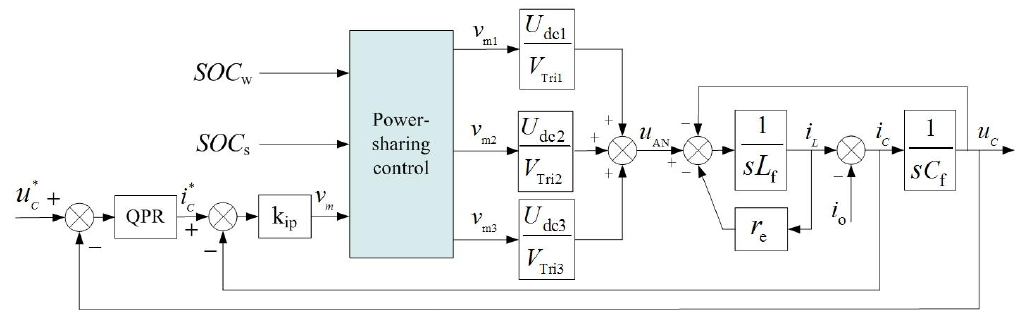
Figure 7. Control of the inverter-link with a power-sharing